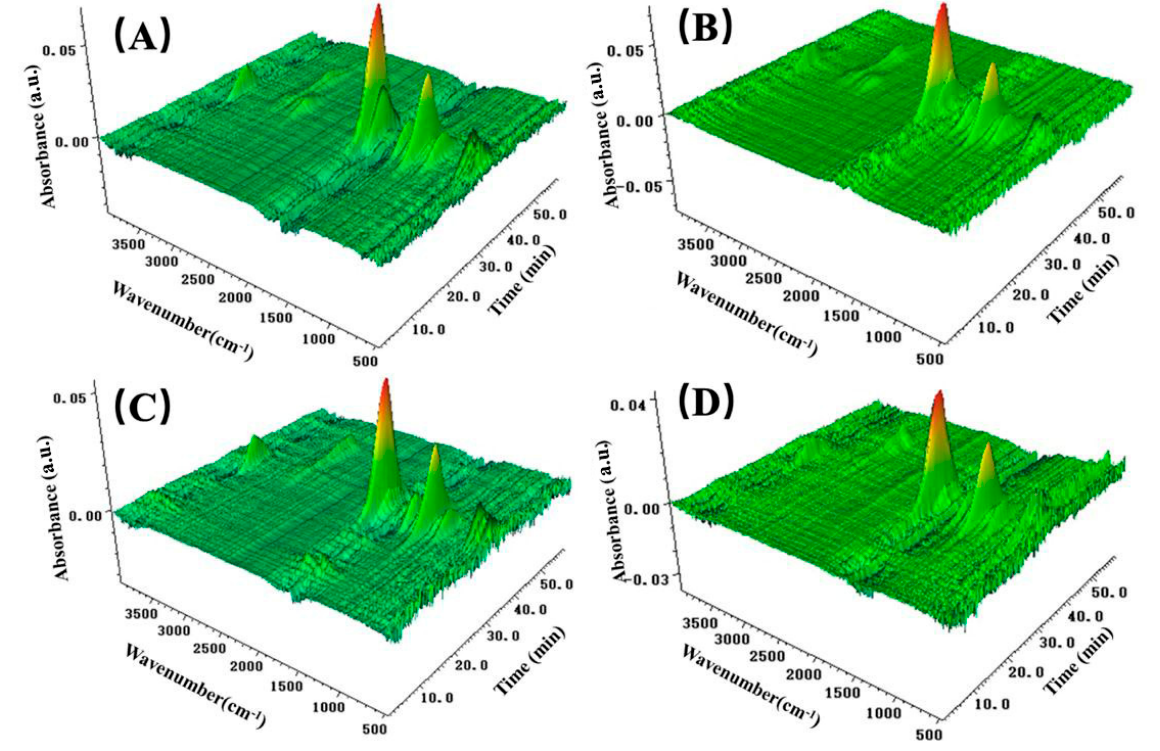
Figure 10. 3D TG-FTIR spectra of the gaseous products of PVA and MXene/PVA nanocomposites: ( A ) PVA; ( B ) MXene 1.0% /PVA; ( C ) PVA-PVPA 10% -PEPA 5% and ( D ) MXene 1.0% /PVA-PVPA 10% -PEPA 5%